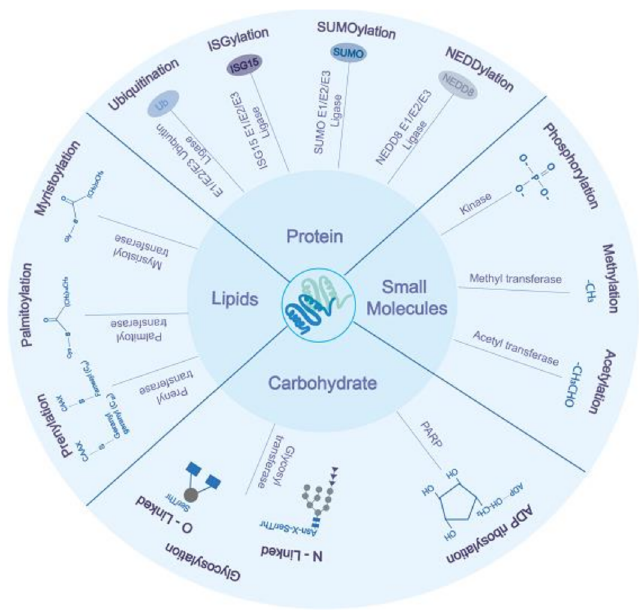
Figure 1. Overview of various post-translational modifications of virus and host proteins having an important role during viral infections. Based on the biochemical nature of attached moieties, post-translational modification (PTMs) can be categorized into modification by small protein groups (ubiquitination, ISGylation, SUMOylation, NEDDylation), carbohydrates moieties (glycosylation, ADP ribosylation), lipids (palmitoylation, myristoylation, and prenylation), and small chemical groups (phosphorylation, methylation, and acetylation). The proteins upon modification result in loss/gain in function, which modulates the virus’s life cycle and host response to virus